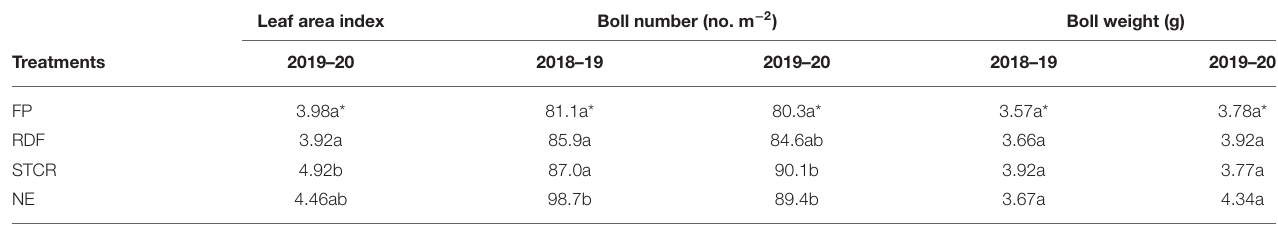
TABLE 2 | Effect of nutrient management practices on leaf area index (LAI), boll number, and boll weight. Leaf area index Treatments